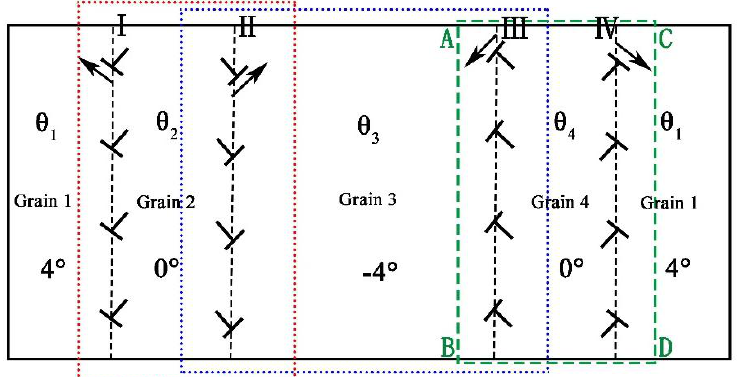
the STGB, ( b ) Tilt angle θ of the STGB and atomic arrangement orientation Φ of the grain, ( c ) The